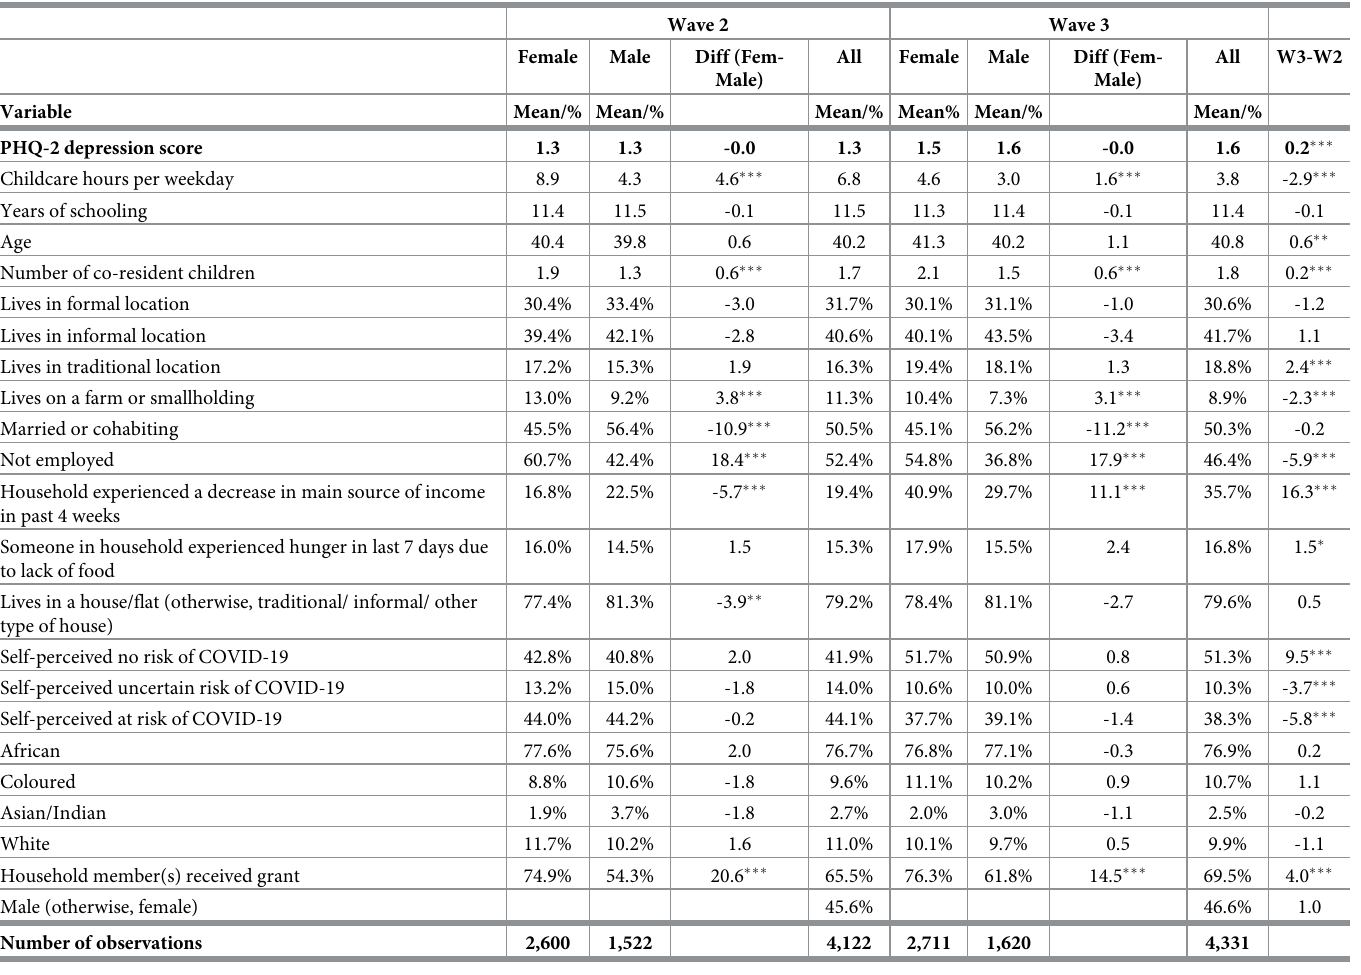
Table 1. Descriptive